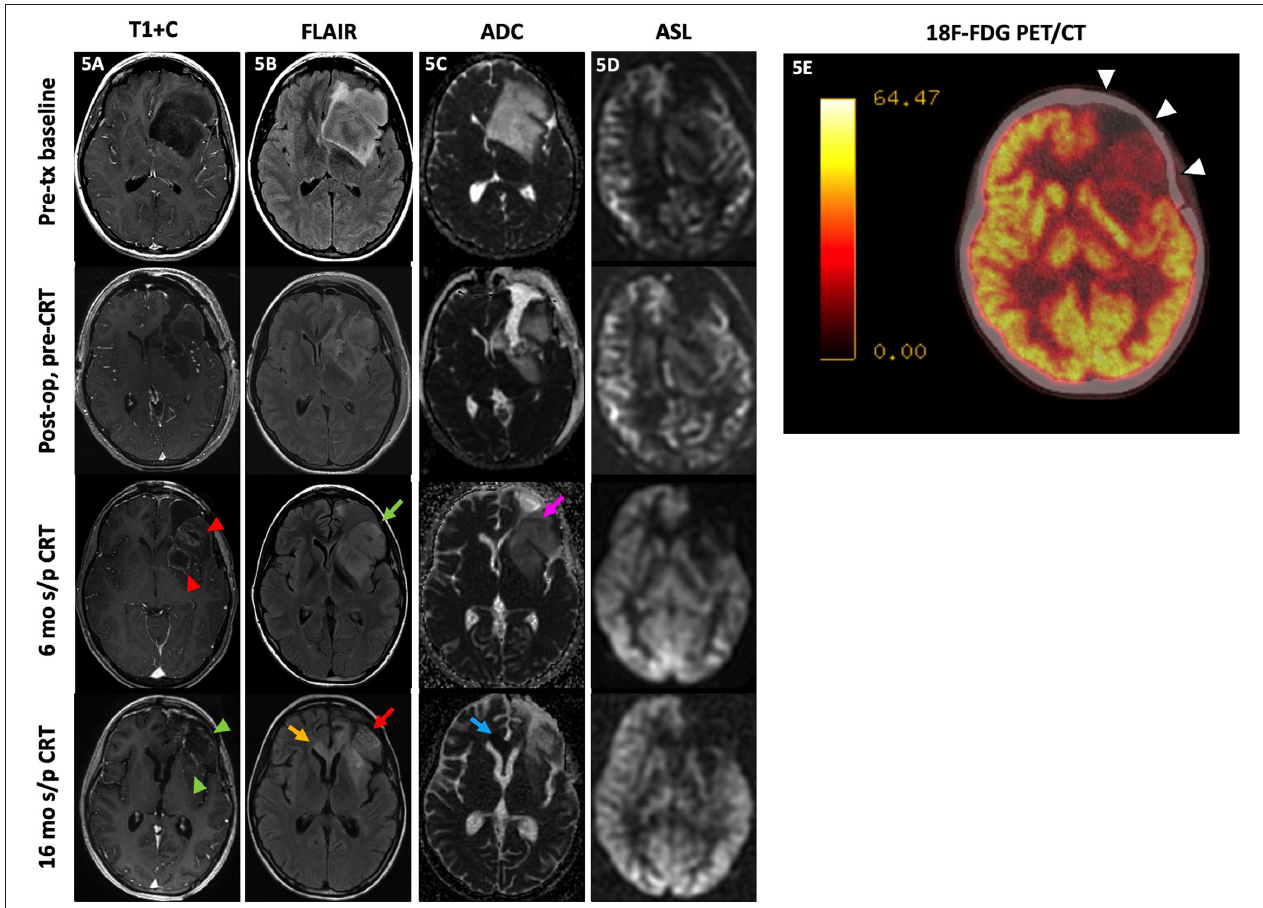
FIGURE 5 | Treatment effect. A 17-year-old female with anaplastic astrocytoma (IDH wt, MGMT + ) initially presented with a predominantly non-enhancing left frontal lobe mass [ (A) , top row] with extensive locoregional mass effect, mild perilesional FLAIR hyperintensity [ (B) , top row], and no substantial diffusion restriction [ (C) , top row] or ASL hyperperfusion [ (D) , top row]. After subtotal resection, there was no substantial enhancement [ (A) , 2nd row] with mild residual FLAIR hyperintensity [ (B) , 3rd row] without diffusion restriction [ (C) , 3rd row] or ASL hyperperfusion [ (D) , 4th row]. At 6 mo s/p CRT, new nodular enhancement was seen at the resection bed margins [ (A) , 3rd row, red arrowheads] with increased expansile FLAIR hyperintensity [ (B) , 3rd row, green arrow], mild diffusion restriction at the anterolateral aspect of the resection margin [ (C) , 3rd row, pink arrow], and persistent lack of hyperperfusion on ASL images [ (D) , 3rd row]. Subsequently, the patient underwent a 18 F-FDG PET/CT a month later which showed hypometabolism throughout the left frontal resection cavity favored to represent treatment effect [ (E) , white arrowheads]. Much later at 16 mo s/p CRT, the left frontal resection cavity showed decreased enhancement [ (A) , 4th row, green arrowheads] with decreased FLAIR signal [ (B) , 4th row, red arrow] at the areas of prior signal abnormality; however, there is a new focal area of FLAIR hyperintensity at the corpus callosum crossing midline [ (B) , 4th row, yellow arrow] with diffusion restriction [ (C) , 4th row, blue arrow] and no ASL hyperperfusion [ (D) , 4th row]. These findings were consistent with delayed Psp/treatment effect at the left frontal resection cavity, which was supported by the PET/CT result, with a new area of probable recurrence at the corpus callosum. The patient did not undergo biopsy and passed away before additional follow-up imaging was obtained. ADC, apparent diffusion coefficient; ASL, arterial spin labeling; CRT, chemoradiotherapy; FDG, fluorodeoxyglucose; FLAIR, fluid-attenuated inversion recovery; mo, months; op, operative; PET/CT, positron emission tomography/computed tomography; s/p, status post;T1 + C, post-contrast T1-weighted images; tx,